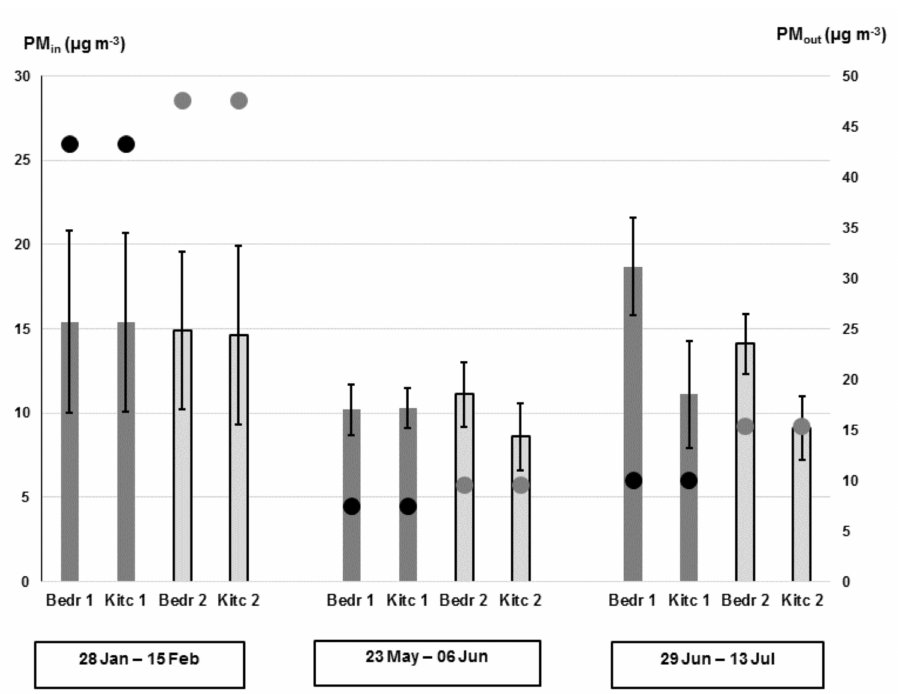
Figure 1. Mean PM 2.5 concentrations measured in the three monitoring campaigns (indicated in the bottom insets). Histograms (left scale): indoor PM 2.5 values measured in each room, kitchen and bedroom; points (right scale): outdoor PM 2.5 values. Error bars represent one standard deviation of the mean. Dark grey histograms and black points represent flat 1 in rural site, light grey histograms and dark grey points represents flat 2 in urban